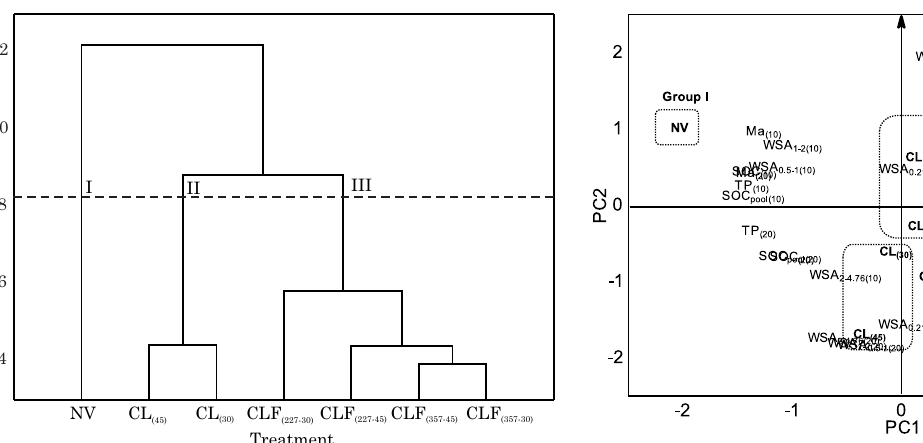
Figure 3. Biplot of principal components PC1 and PC2 of the principal component analysis with all soil samples and variables: bulk